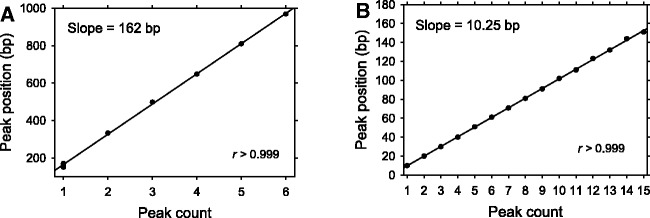
Linear regression analysis of the peak positions for the inter-nucleosome DAC function (Figure 2). (A) Linear fit of the peaks shown in Figure 2A (positions 151, 162, 171, 333, 498, 648, 810 and 969). The straight line has a slope of 162 bp (r = 0.9999). (B) Linear approximation of the sub-peaks shown in Figure 2B (positions 10, 20, 30, 40, 51, 61, 71, 81, 91, 102, 111, 123, 132 and 144 bp). The straight line has a slope of 10.25 bp (r = 0.9999).